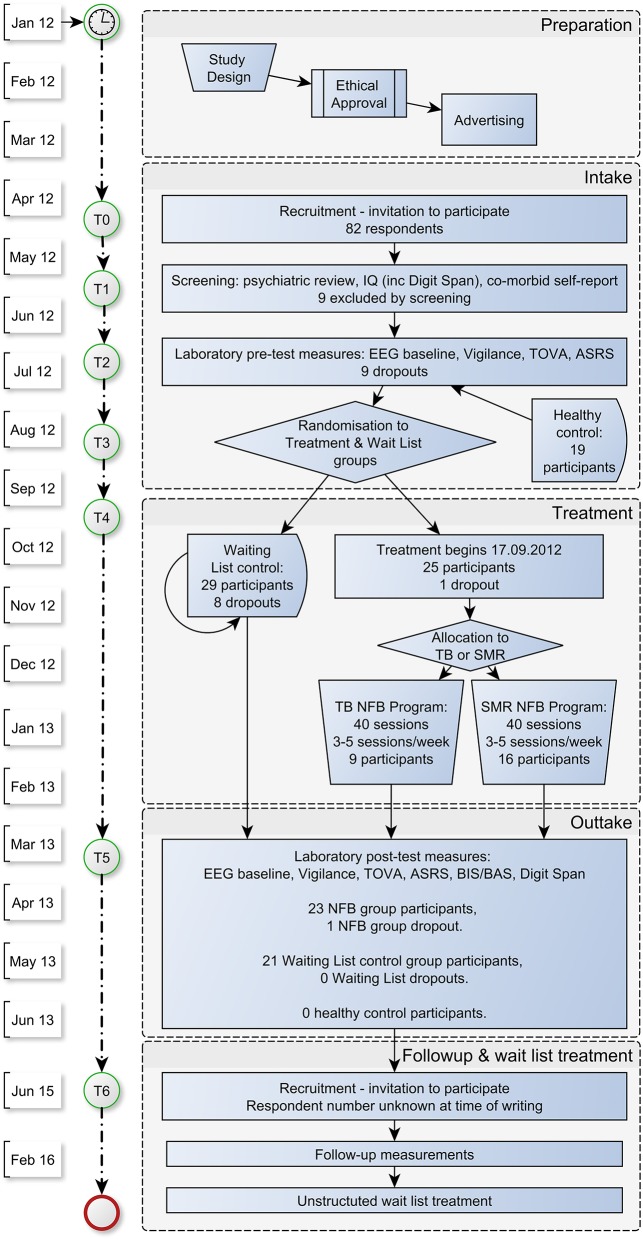
Flow chart of assessments and treatments in the CENT trial.